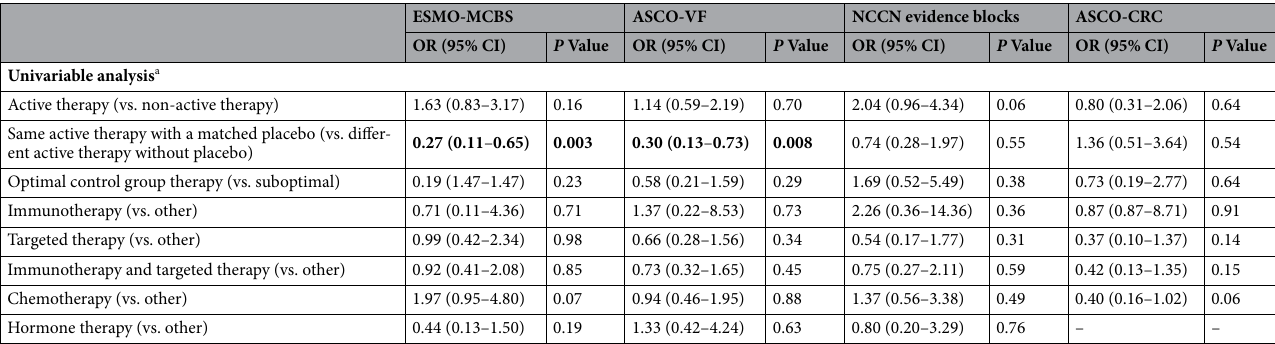
Table 3. Association between characteristics of control group therapy and clinical benefit. Statistically significant values are in bold. ESMO-MCBS ESMO-Magnitude of Clinical Benefit Scale, ASCO-VF ASCO- Value Framework, NCCN National Comprehensive Cancer Network, ASCO-CRC ASCO-Cancer Research Committee, OR odds ratio, CI confidence interval, OS overall survival, QoL quality of life. a Based on univariable logistic regression. All P values are 2-sided.